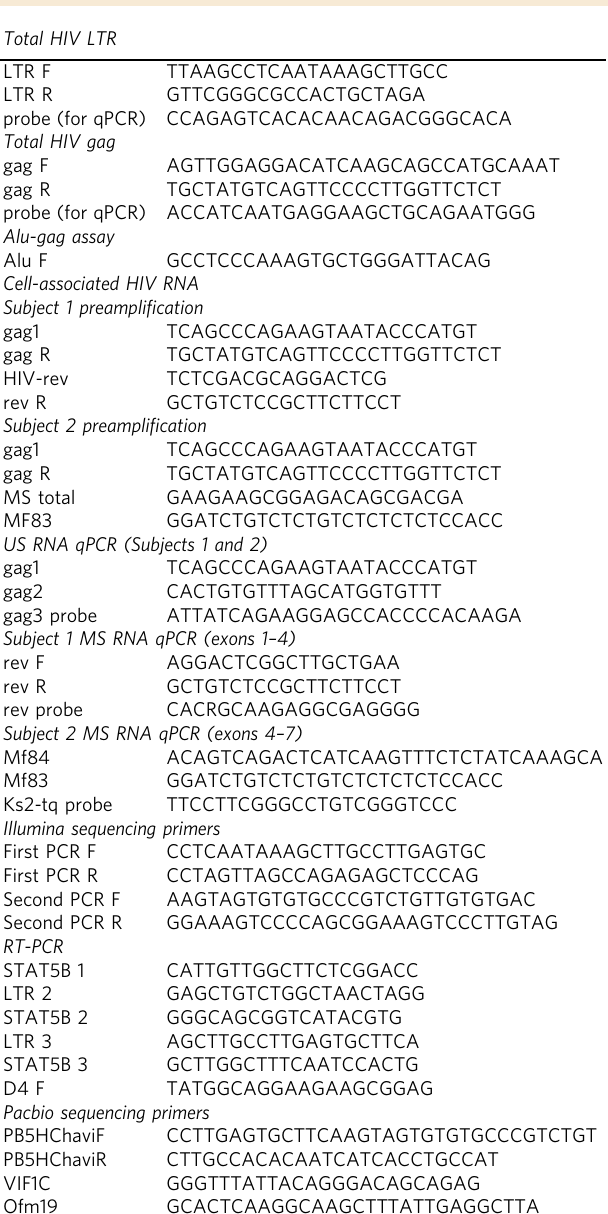
Table 1 List of primers used in the